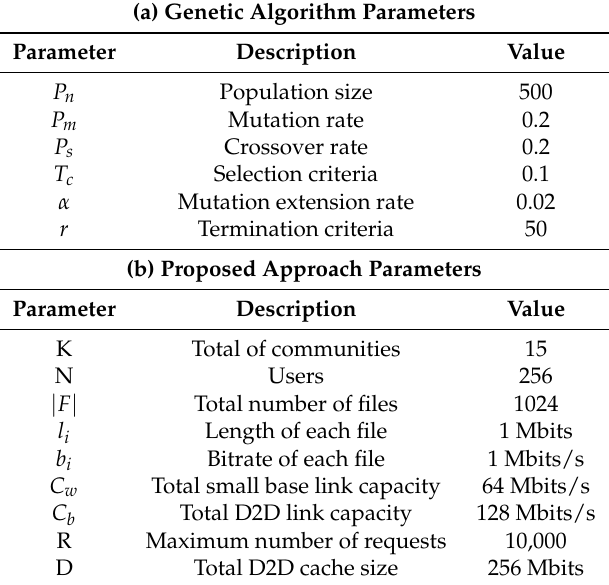
Table 2. Simulation